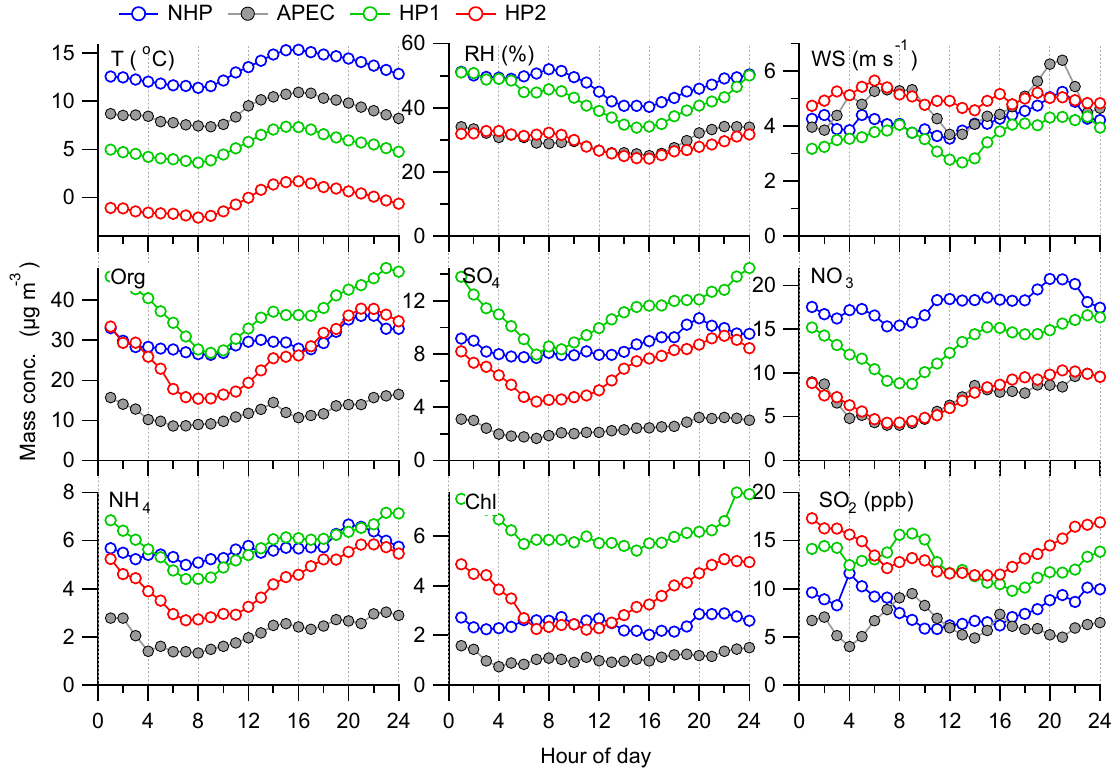
Figure 4. Diurnal variations in meteorological parameters (RH, T , WS), NR-PM 1 species, and SO 2 during the four different periods, i.e., NHP, APEC, HP1, and